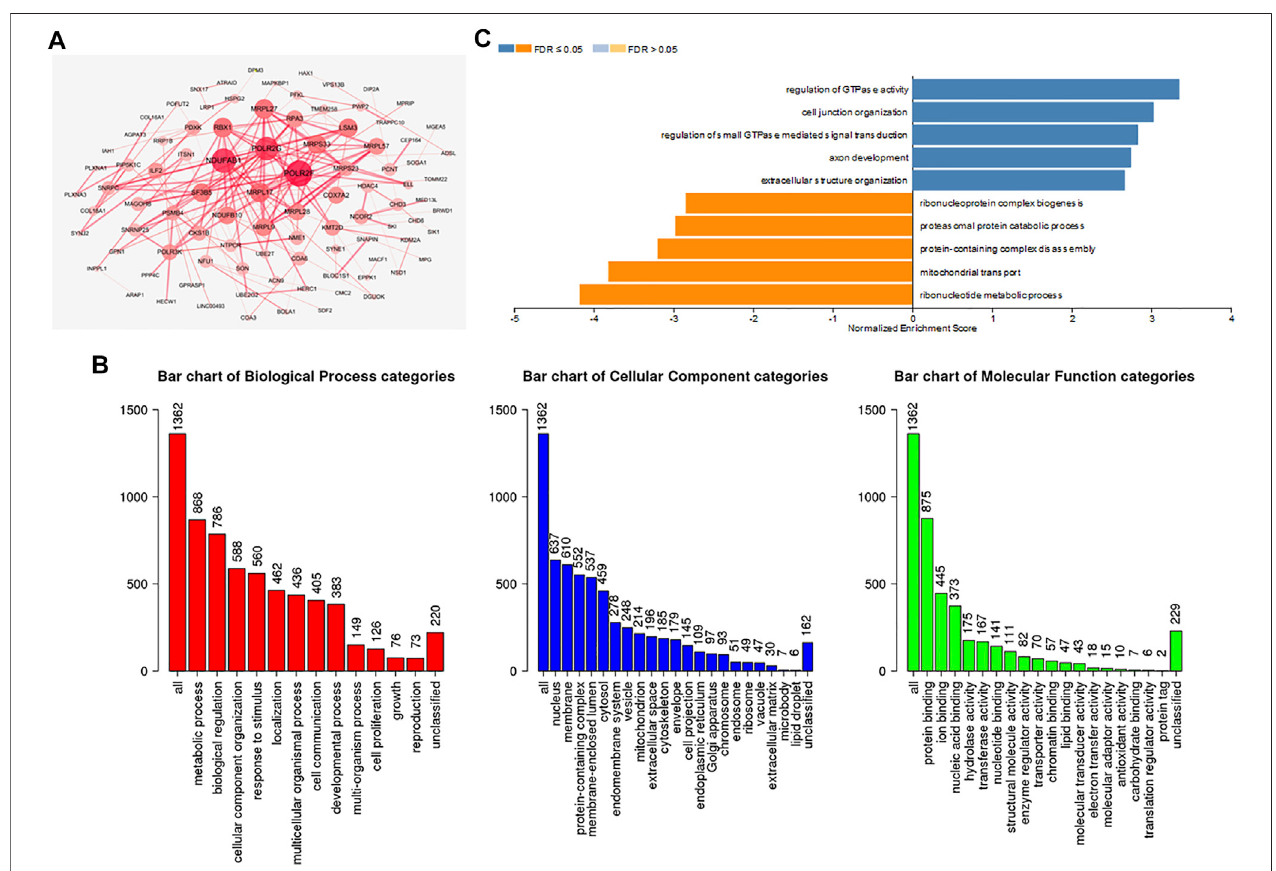
FIGURE 7 | Functional enrichment analysis of ADARB1-associated coexpressed genes in OC. (A) A protein-protein interaction network of ADARB1-associated coexpressed genes drawn by the STRING and Cytoscape software. (B) GO analysis of ADARB1 associated coexpressed genes were identi fi ed by Webgestalt database. (C) The KEGG pathways of ADARB1-associated coexpressed genes were identi fi ed by Webgestalt database.